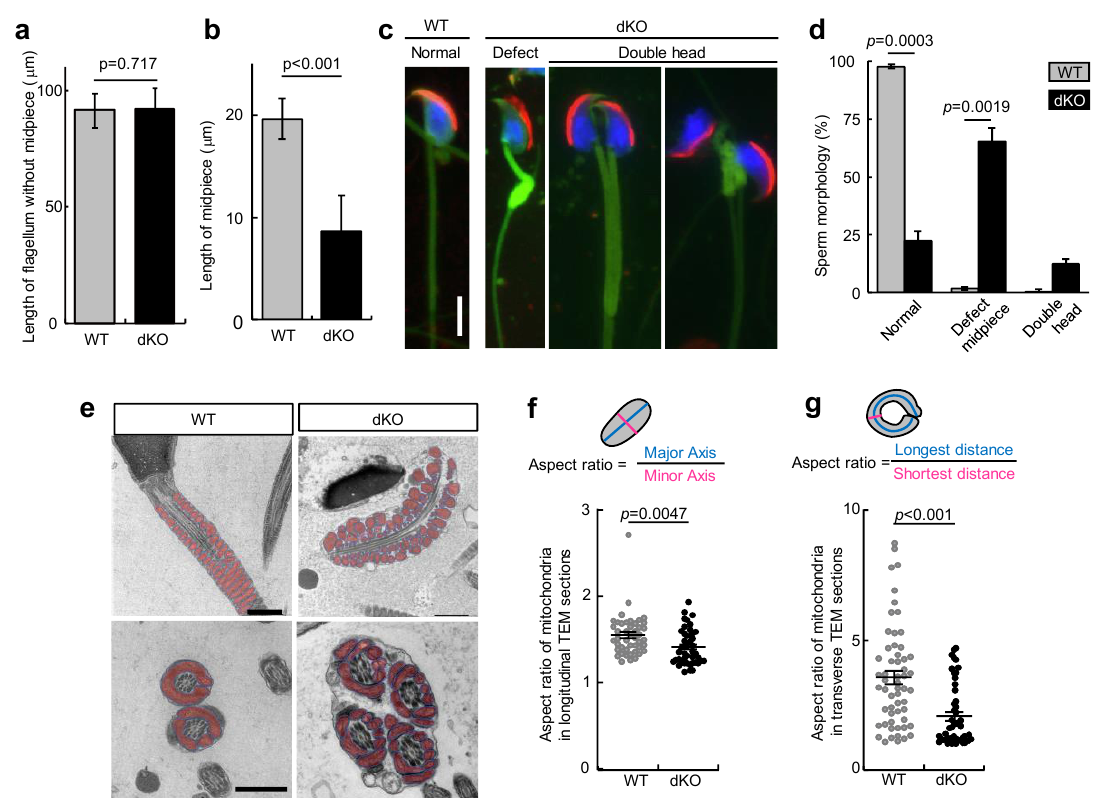
Figure 4. Mitochondrial defects of epididymal sperm of Psme4/Ecpas dKO mice: ( a ) Total flagella length without midpiece of sperm. Data are expressed as the mean ± standard error. ( b ) The midpiece length of sperm. Data are expressed as the mean ± standard error; ( c ) Fluorescent images of sperm’s head and midpiece stained with PNA (red), DAPI (blue), and MitoTracker (green); scale: 5 µ m; ( d ) The ratio of sperm with defective midpiece and double head. Data are expressed as the mean ± standard error; ( e ) Transmission electron microscope (TEM) images of the sperm midpiece mitochondrion (highlighted in red): (upper) longitudinal section; (lower) transverse section; scale: 1 µ m; ( f ) Aspect ratio of sperm mitochondria in longitudinal TEM sections. Scatter plot is individual values ( n = 45). Lines and error bars expressed as the mean ± standard error; ( g ) Aspect ratio of sperm mitochondria in transverse TEM sections. Scatter plot is individual values ( n = 57). Lines and error bars are expressed as the mean ± standard